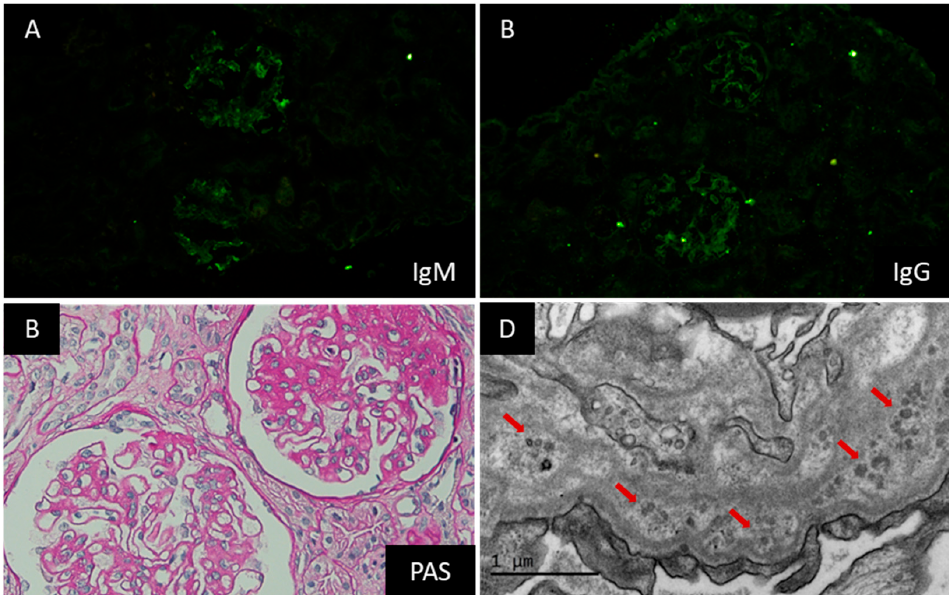
Figure 1. Representative pathological images of renal biopsy specimen form Case 1. Note: IF staining was positive for IgM ( A ) and IgG ( B ) in capillary walls and mesangial regions. Light microscopy indicated mild mesangial matrix expansion and diffuse thickening of GBM (( C ), PASM + Masson, 400×). Electron microscopy showed thickening of the GBM, diffuse podocyte foot process effacement, and prominent microspheres forming clusters (red arrow) within the GBM (( D ), 20,000×).